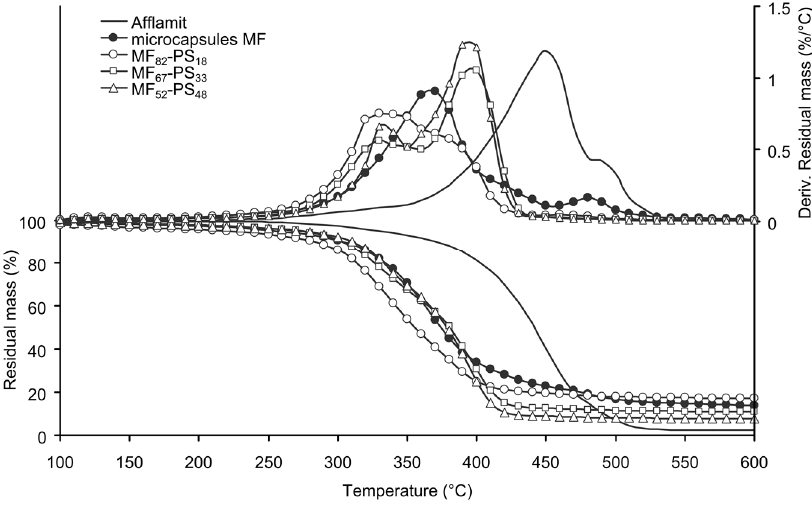
Figure 6. TG and DTG of RDP, MF microcapsules and PS-based microcapsules (N 2 , 10 °C/min).